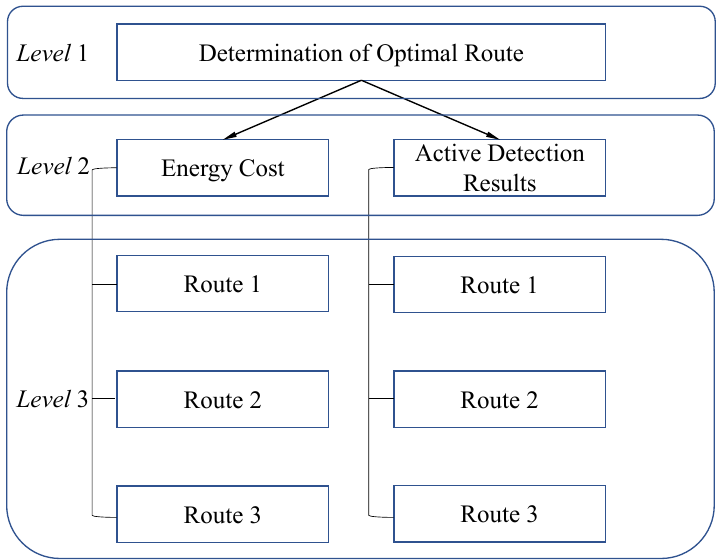
Figure 5. Problem structure setup by AHP.